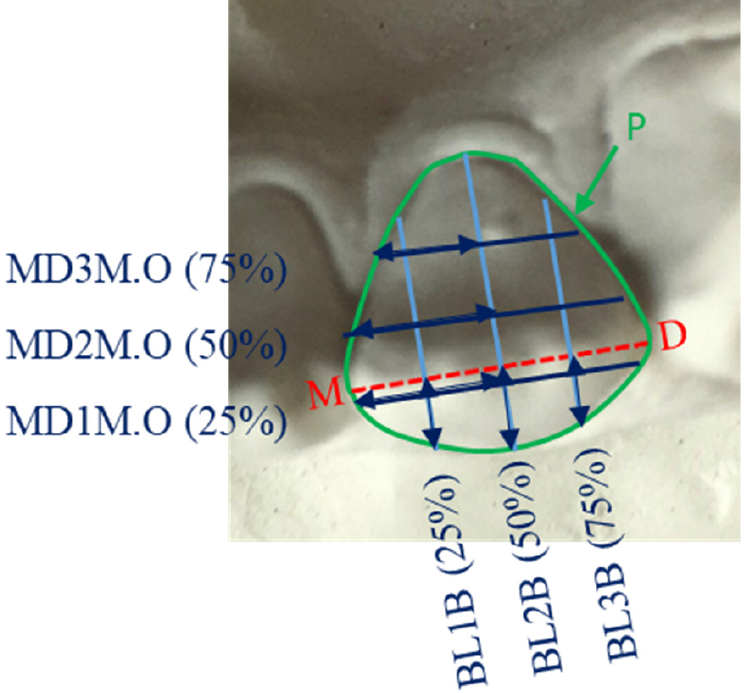
Figure 4. Occlusal view of a lower left lateral incisor partial measurements: MD1M.O, MD2M.O and MD3M.O are the mesial parts of the mesio-distal measurements at 25, 50 and 75% along BL2, respectively and determined by BL2; BL1B, BL2B and BL3B are the buccal parts of the bucco-lingual measurements at 25, 50 and 75% along the MD, respectively and determined by the MD.